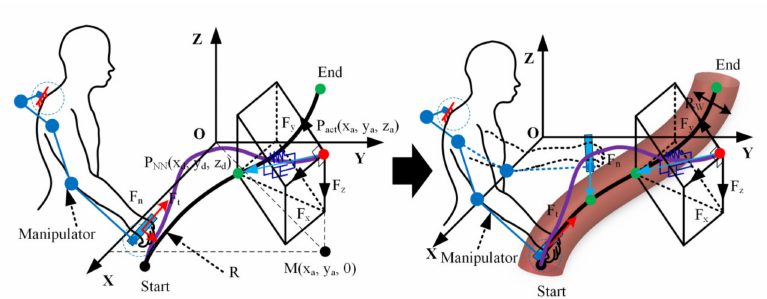
Figure 5. Schematic diagram of enhancing the spatial virtual fault-tolerant region.